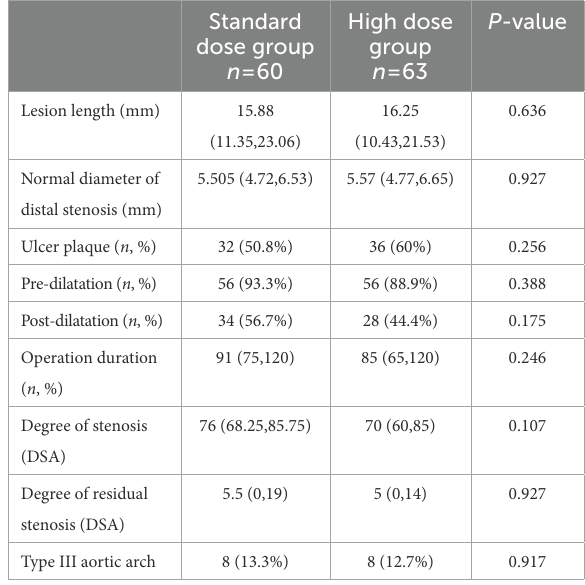
TABLE 1 The baseline of patients’ characteristics, preoperative serology and surgical